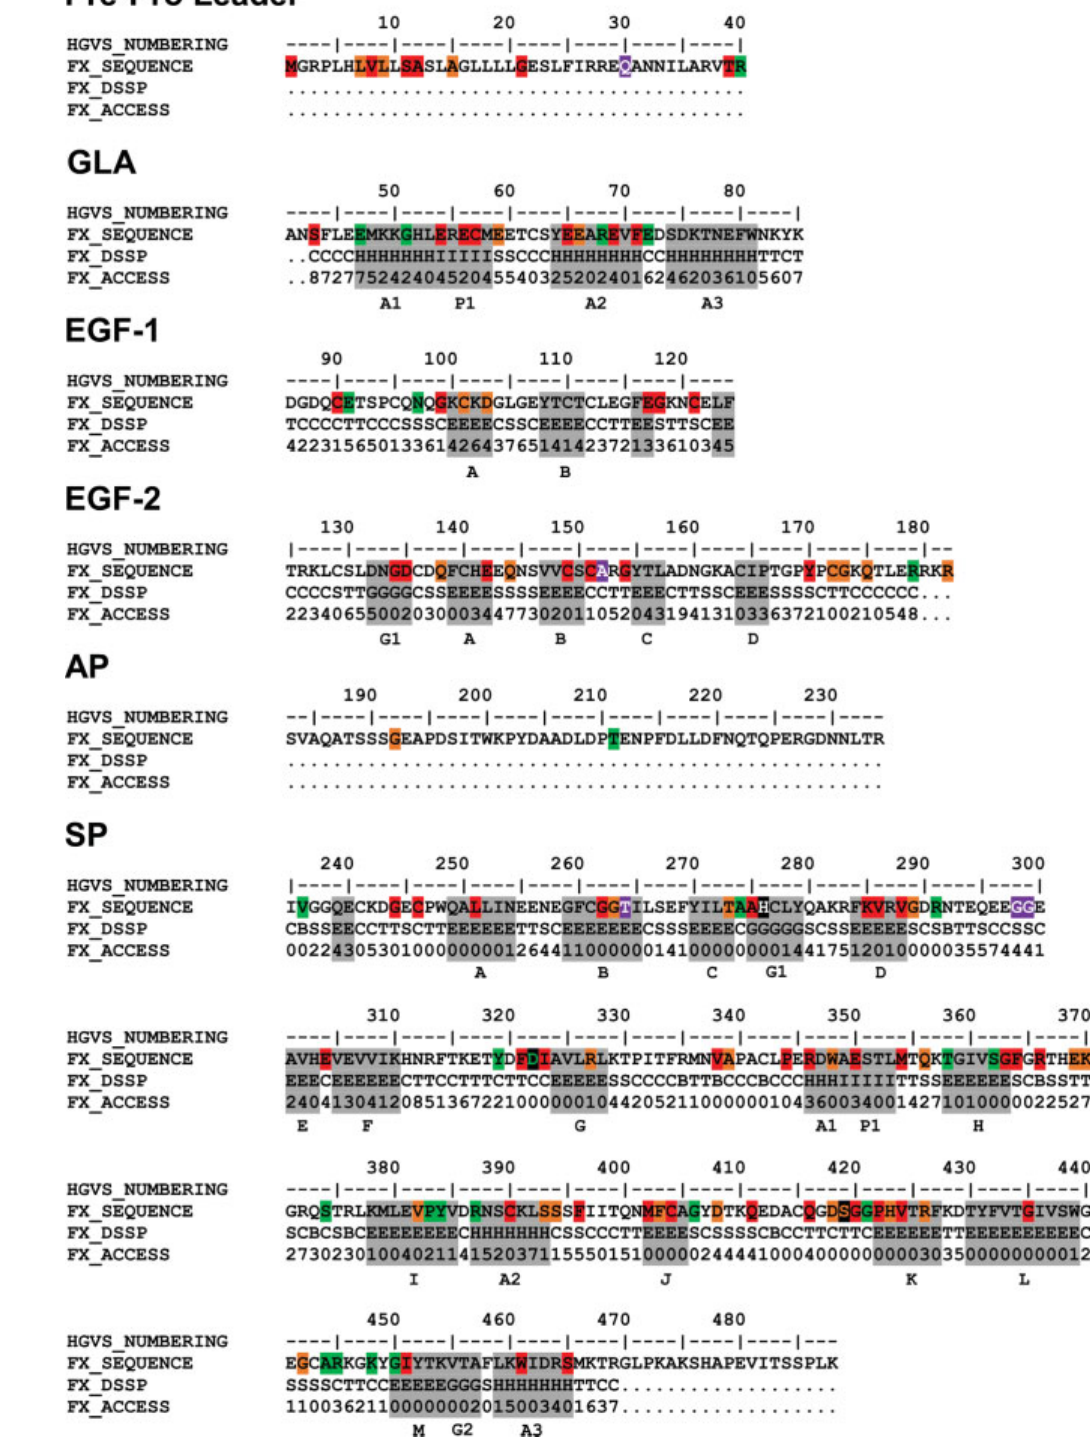
Fig.4 Secondary structureandaccessibility analysisof variantsin the mergedFXacrystal structure. Thefactor X (FX) sequence isshown withthe major secondary structure assignments highlighted in gray boxes. Residues are denoted either H ( α -helix), B ( β -bridge), E (extended β -strand), G (3 10 helix), I ( π -helix), T (hydrogen-bonded turn), S (bend), or C (unde fi ned coil region). The SP catalytic triad His276-Asp322-Ser419 is highlighted in black. β -strands are labeled alphabetically in the order in which they occur. The β -strands in the EGF-1, EGF-2 and SP domains are denoted A-B, A-D, and A-M respectively. The α -helices are denoted A1-A3, 3 10 -helices G1-G2, and π -helices P1. The positions of 136 point variants found in the F10 gene are highlighted in boxes, where 57 red boxes denote type-I mutations, 26 green boxes denote type-II mutations, and 33 orange boxes denote mutations with unknown phenotype. Several boxes correspond to multiple variants at one residue position. The fi ve purple boxes denote nondisease associated polymorphisms. All numbering is in HGVS format. AP, activation peptide; EGF, epidermal growth factor; GLA, γ -carboxyglutamic acid; SP, serine protease.